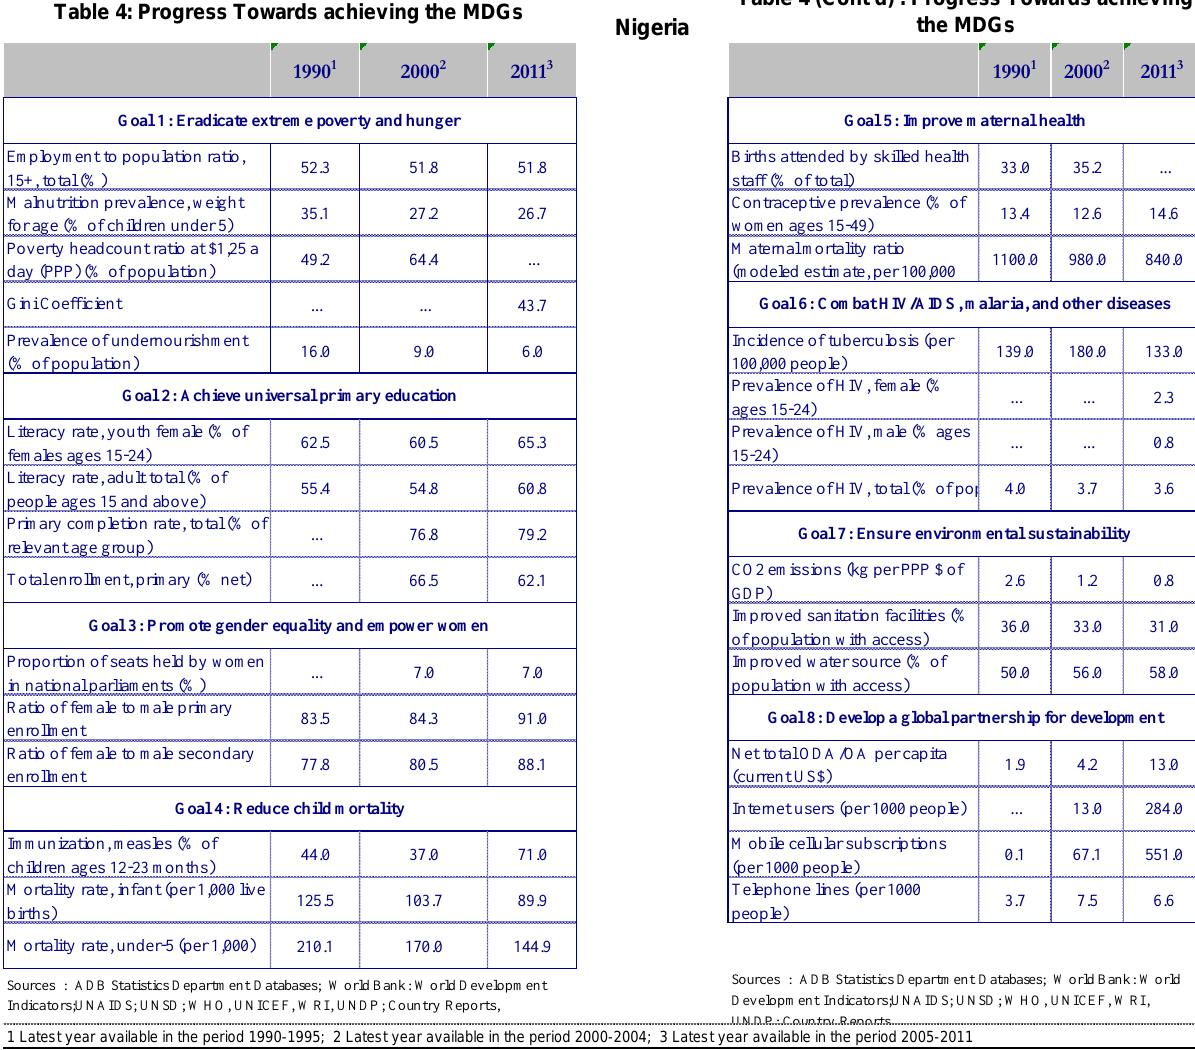
Table 4 (Cont'd) : Progress Towards achieving the MDGs